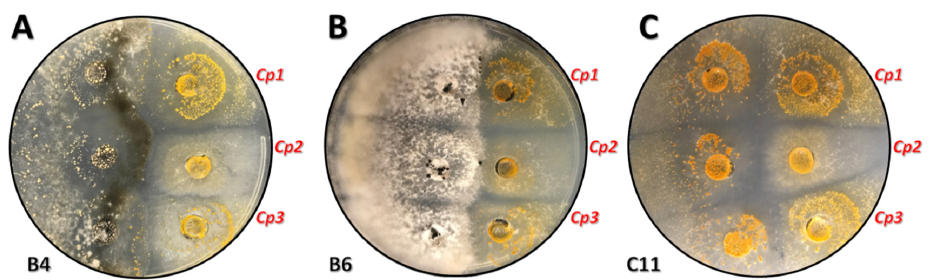
Figure 5. Conversion attempts. Isolates from Site B ( A , B ) and Site C ( C ) were plated with pure strains of Cp1 , 2 , and 3 to